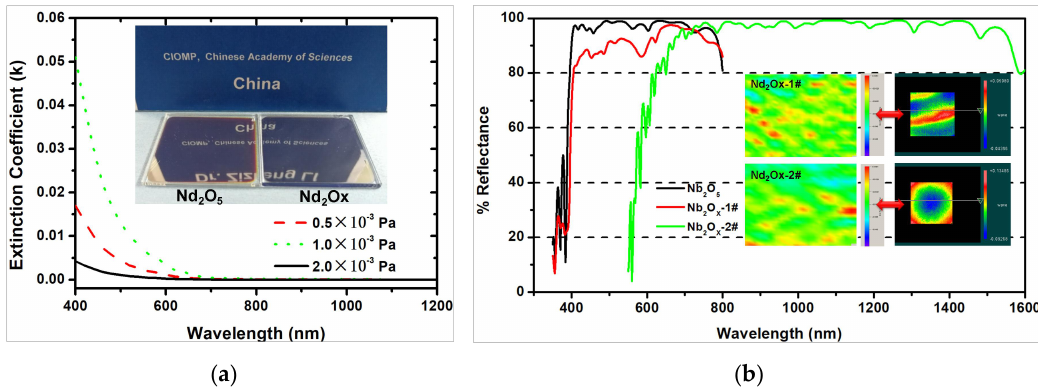
Figure 7. ( a ) The dependence of the extinction coefficient on oxygen partial pressure; ( b ) Reflectance, coating stress, and surface shape of HR coating samples with different oxygen partial